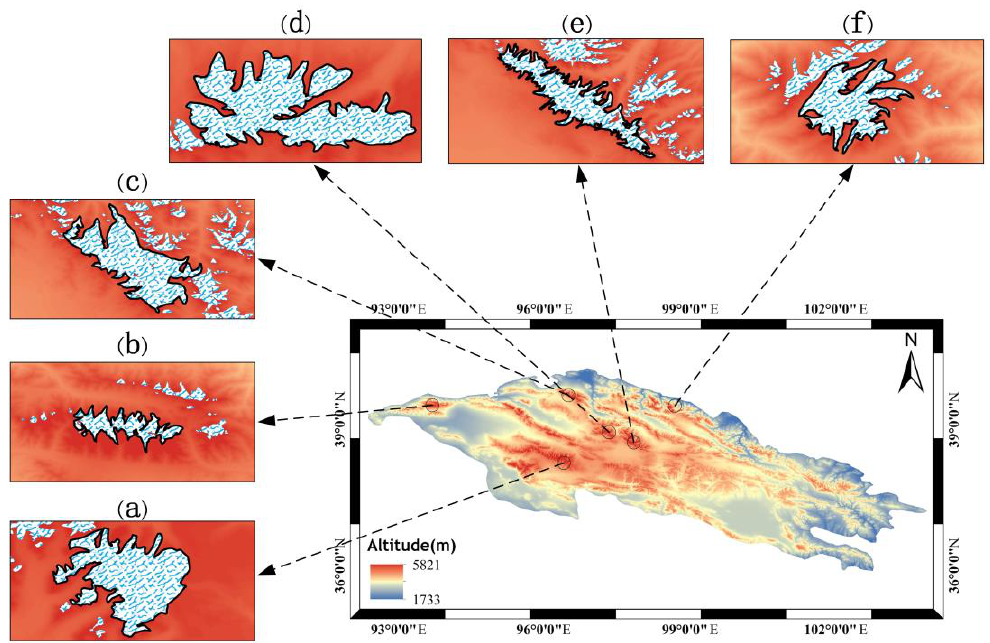
Figure 1. An overview of the Qilian Mountains on the northeastern edge of the Qinghai-Tibet Plateau. ( a ) Dunde Ice Cap ( b ) Glacier at 93.5 ◦ E 39.2 ◦ N ( c ) Laohugou No. 12 Glacier (and its surrounding glaciers) ( d ) Glacier at 97.2 ◦ E 38.7 ◦ N ( e ) Gangnalou Glacier (and its surrounding glaciers) ( f ) Shiyang River, Bayi, Suzhu Chain Glacier